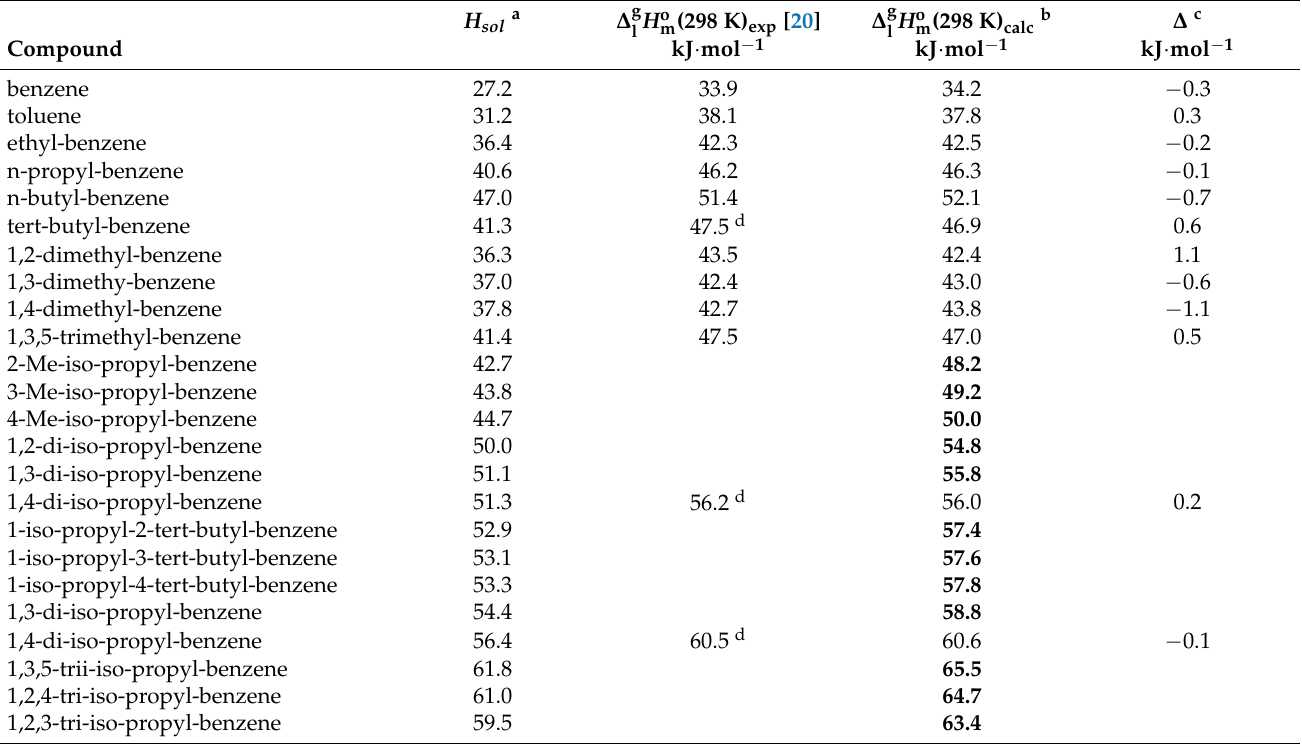
Table 6. Correlation of the vaporisation enthalpies, ∆ g with their solution enthalpies ( H sol